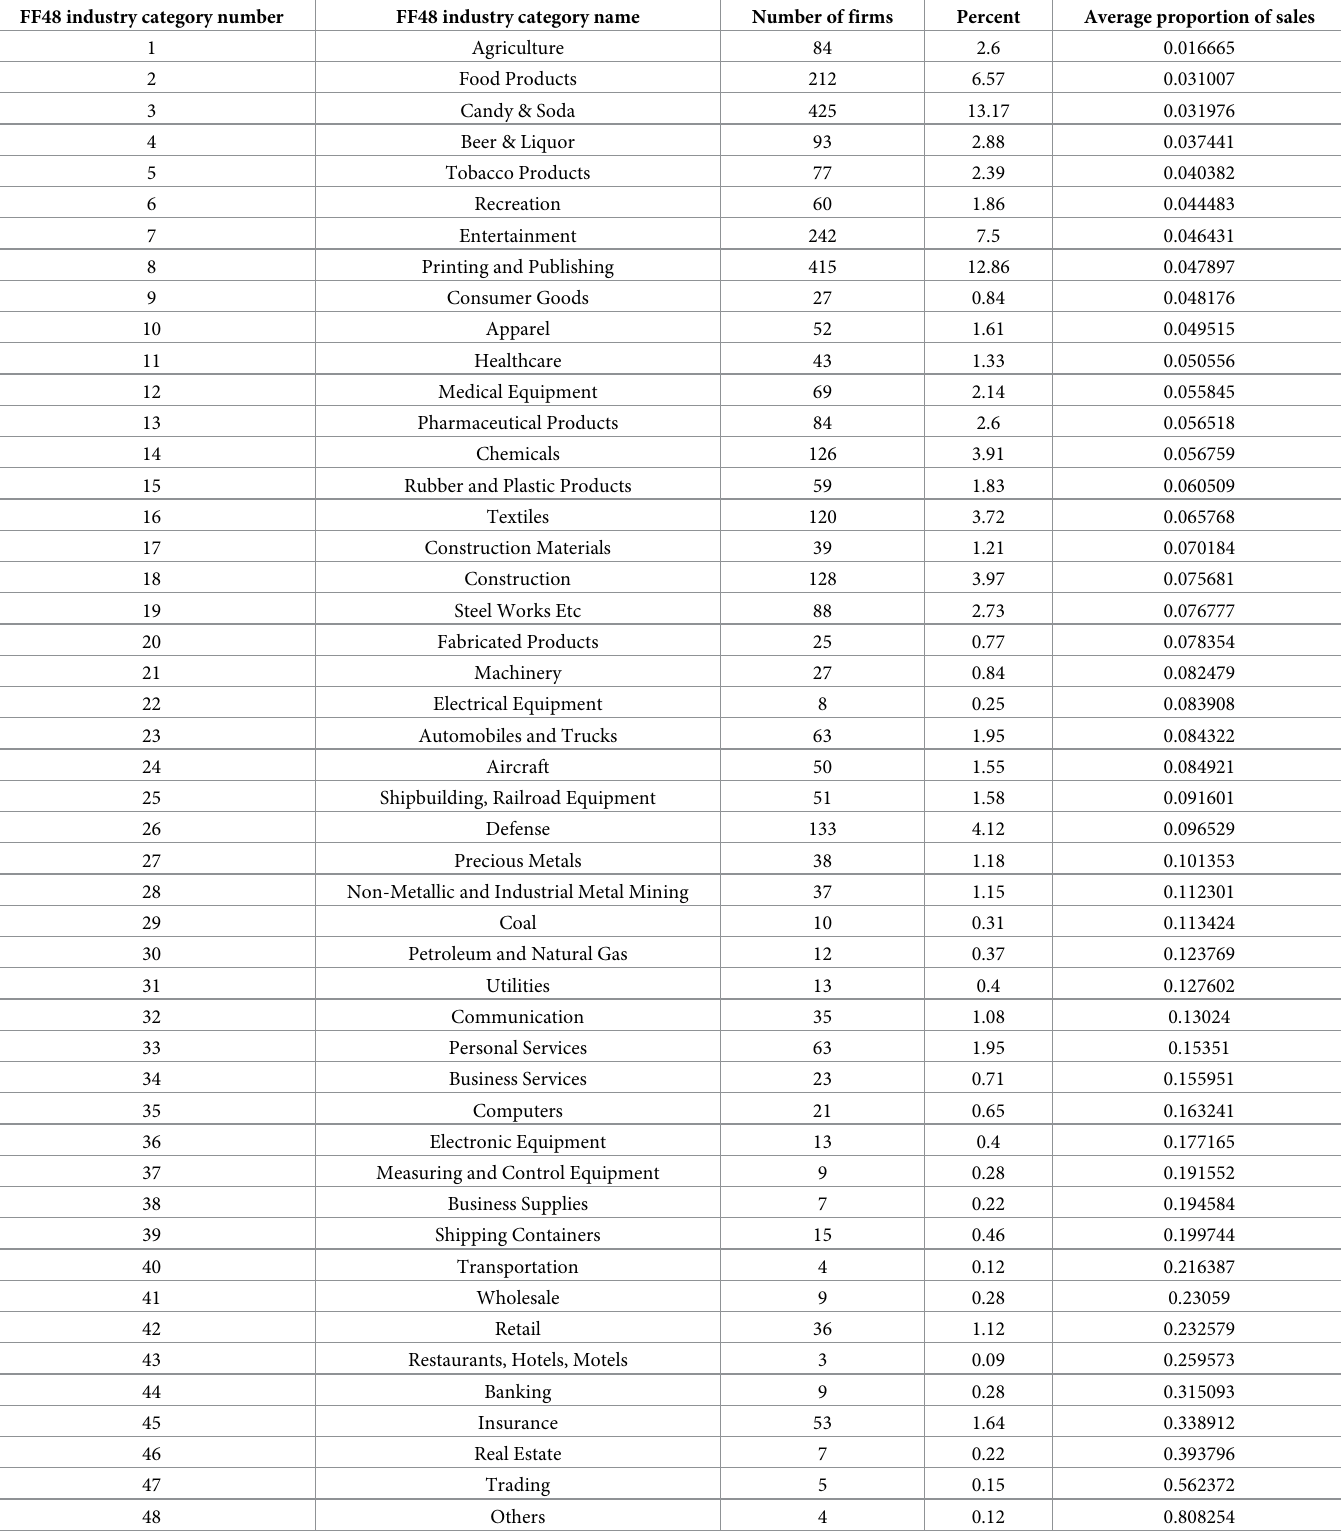
Table 2. Industry-wise sample distribution. FF48 industry category